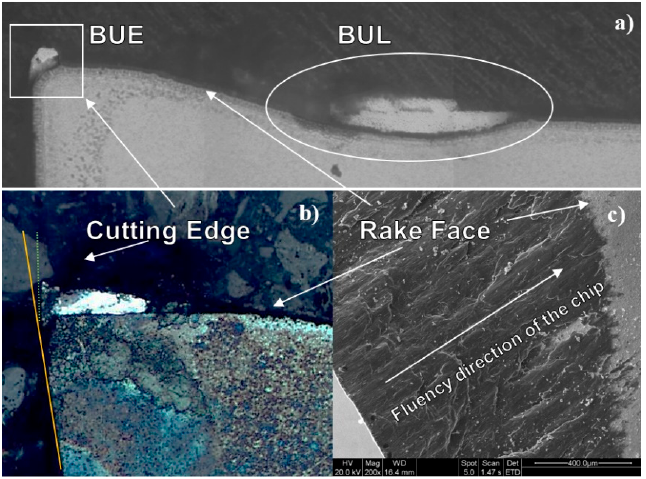
Figure 9. ( a ) Cross-section of the tool. ( b ) Overlapped layers of adhered material. ( c ) SEM of stratified structure of adhered